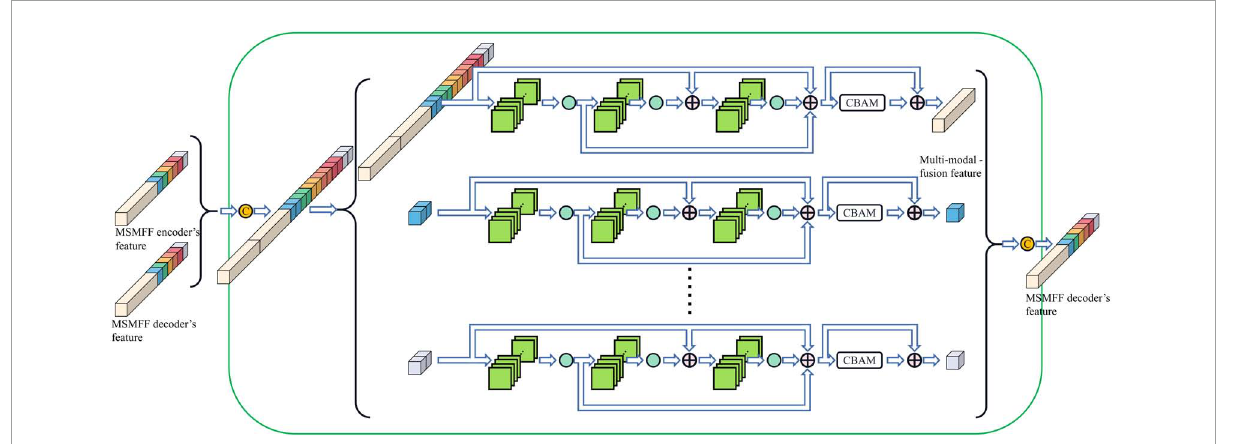
FIGURE5 Modality-specific and multi-modal fusion feature decoder